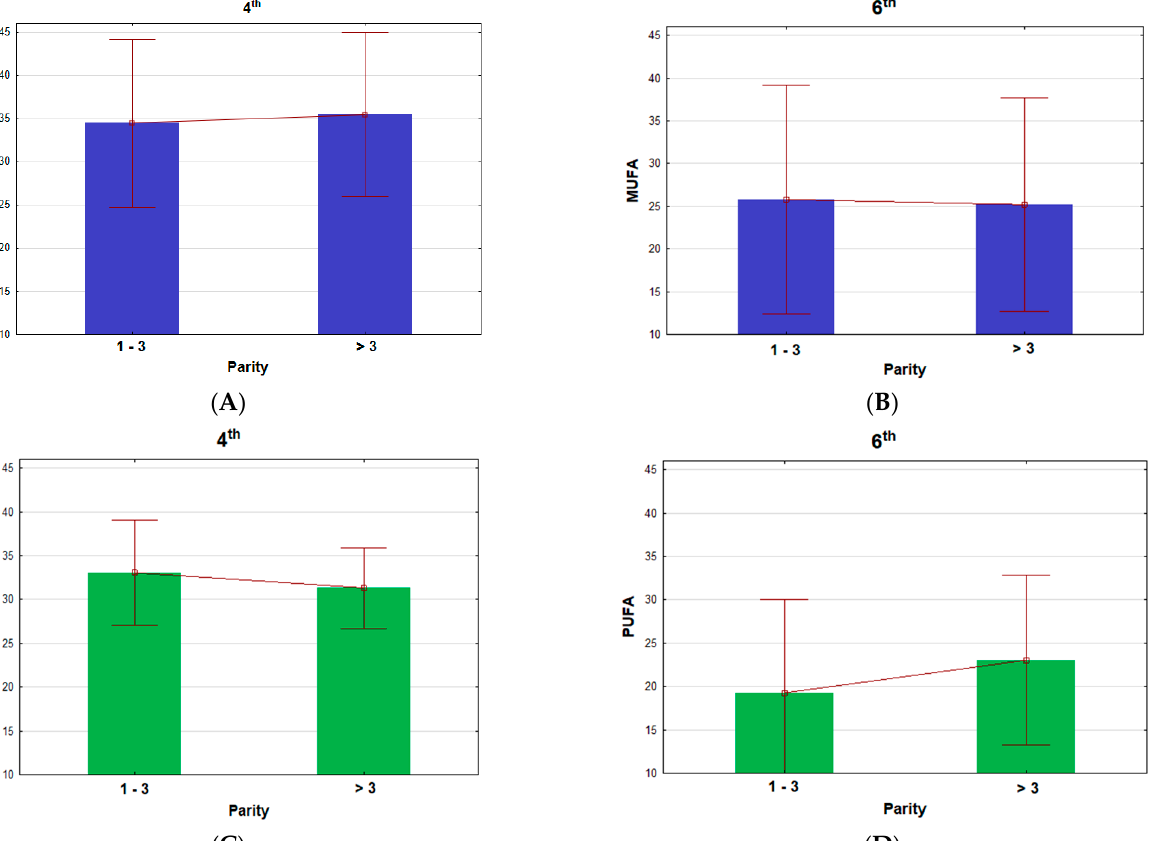
Table 5. LSMs of the composition of healthy fatty acid and ratios between fatty acids in mare’s mil.